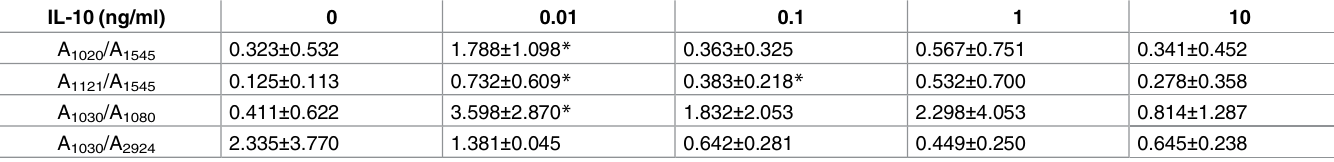
Table 2. Infrared absorption intensities of mDCs cultured in different concentration IL-10 conditioned medium (Mean SD). IL-10